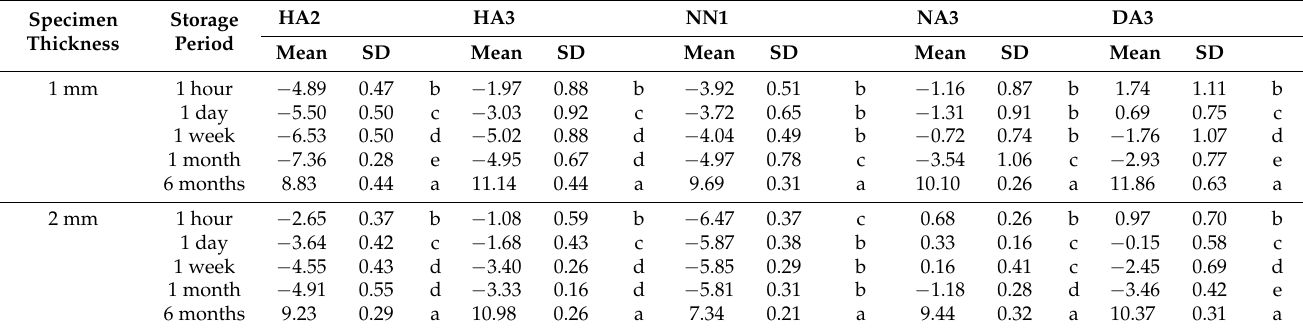
Table 4. Mean b* values of the 3D printable material specimens after different storage periods. Specimen